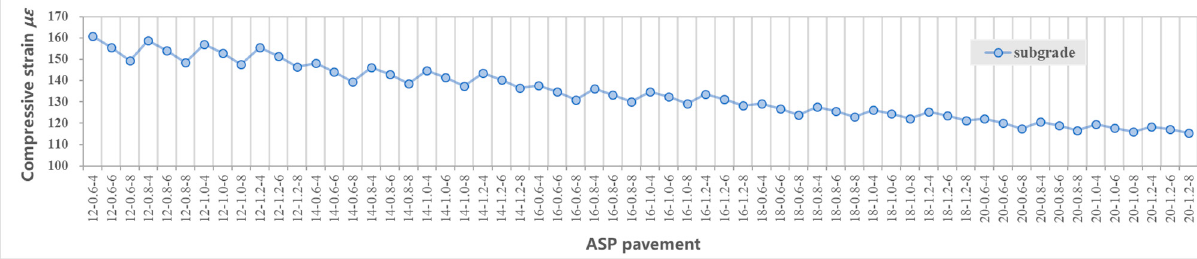
Figure 5. Tensile (horizontal) strain at the bottom of each layer of ASP pavement with different thicknesses.